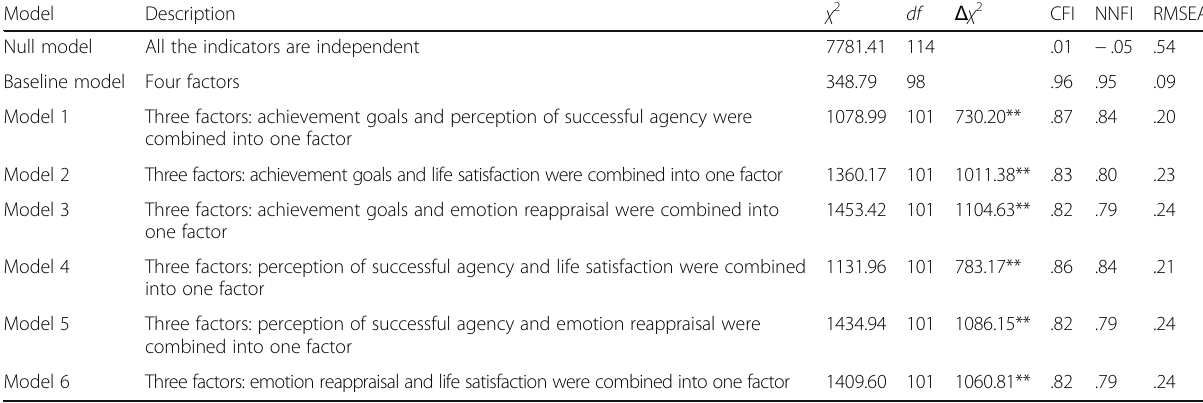
Table 1 Comparison of results from the measurement models Model Description Null model All the indicators are independent Baseline model Four factors Model 1 Three factors: achievement goals and perception of successful agency were combined into one factor Model 2 Three factors: achievement goals and life satisfaction were combined into one factor Model 3 Three factors: achievement goals and emotion reappraisal were combined into one factor Model 4 Three factors: perception of successful agency and life satisfaction were combined into one factor Model 5